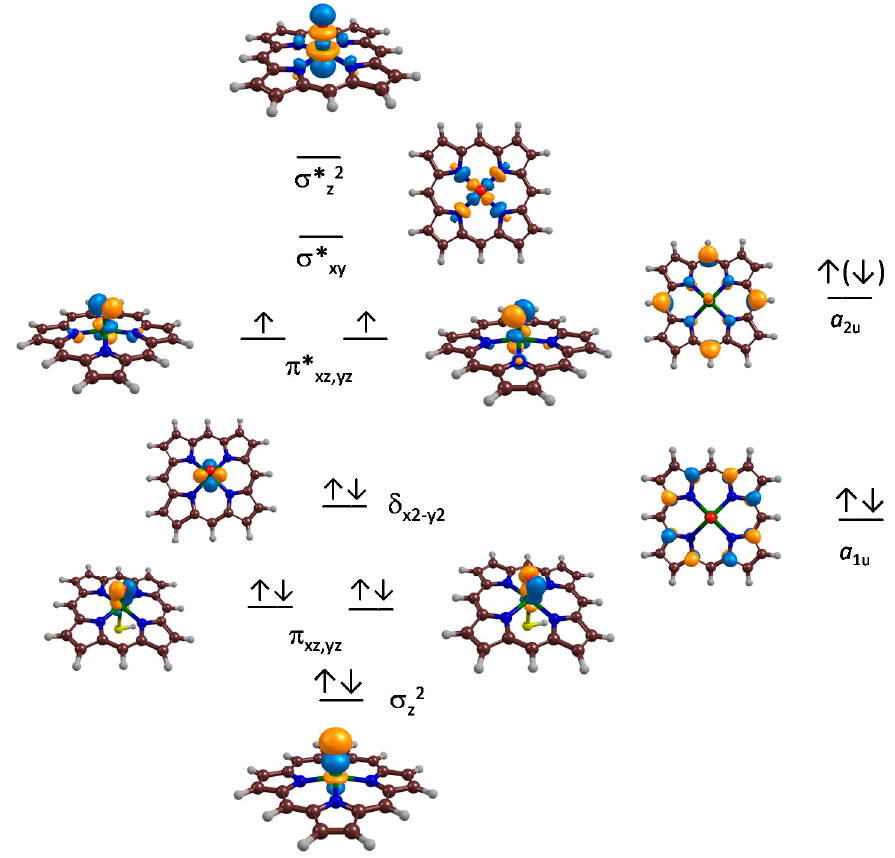
Figure 4. Relevant molecular orbitals of P450 CpdI and orbital occupation in the quartet and doublet spin-states.